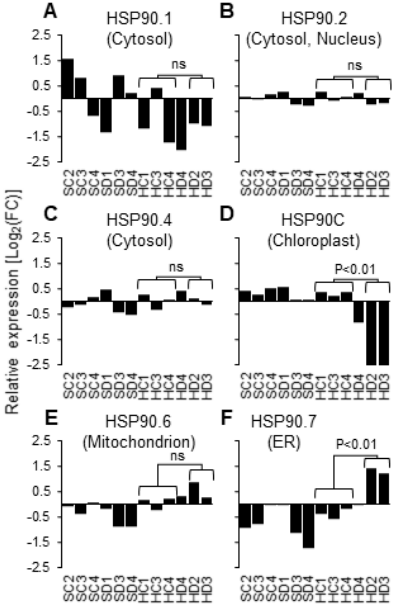
Figure 2. Expression changes of HSP90 family genes in RNA-seq samples. Relative normalized read counts in all RNA-seq samples are shown for tobacco homologs of Arabidopsis HSP90 family genes: ( A ) cytosolic HSP90.1; ( B ) nucleo-cytosolic HSP90.2; ( C ) cytosolic HSP90.4; ( D ) chloroplast HSP90C or HSP90.5; ( E ) mitochondrial HSP90.6; ( F ) ER-localized HSP90.7. Statistical significance of the difference in read counts was evaluated between control-treated (HC1, 3, and 4) and Dex-treated (HD2 and 3) in DESeq2 analysis. ns, not significant. Data from the HD4 sample were omitted as